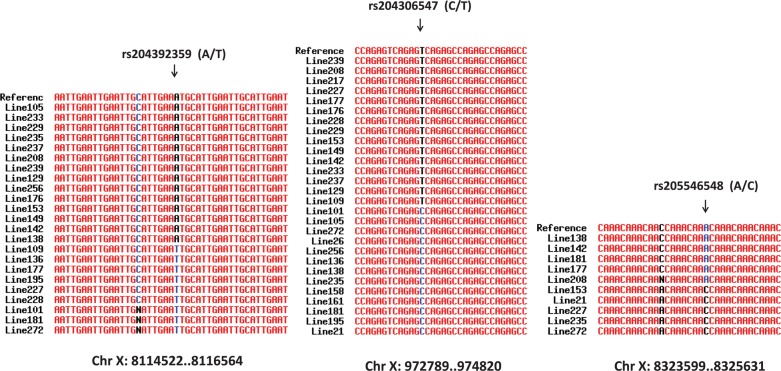
Multiple sequence alignment of microsatellite loci among different inbred lines of D. melanogaster. The chromosomal position of the microsatellite loci is shown below the alignment. The inbred line ID corresponding to each sequence is shown. The reference SNP identified in D. melanogaster (dbSNP data) is shown by a downward arrow along with SNP ID and alleles.